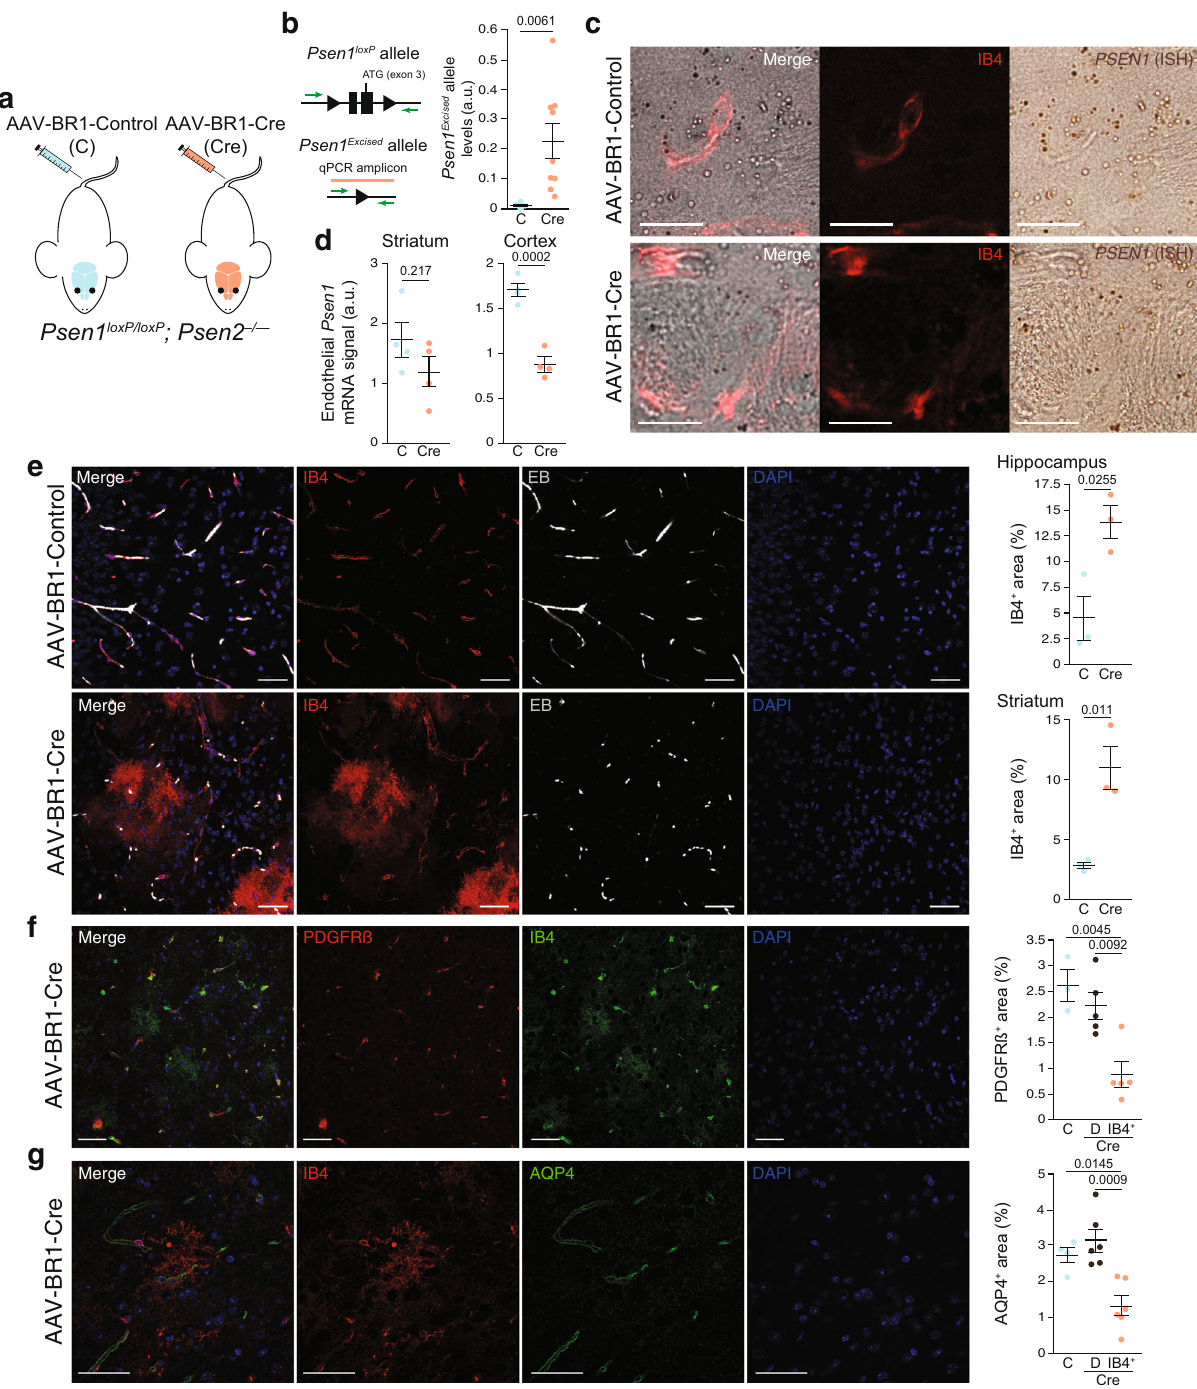
Fig. 4 In adult inhibition of endothelial γ -secretase activity is suf fi cient to generate IB4 + vascular abnormalities. a Schematic representation of a mouse model with adult inhibition of endothelial γ -secretase activity. Psen1 loxP/loxP ; Psen2 – / – mice were injected with cerebral endothelium-speci fi c adeno- associated control (AAV-BR1-Control; C) or Cre recombinase-expressing (AAV-BR1-Cre; Cre) viruses. b Schematic representation of the qPCR amplicon used to detect the Psen1 excised allele (orange bar). Right graph: Quanti fi cation of the degree of Psen1 excision (a.u., arbitrarty units) in the striatum of C and Cre mice. Mean ± SEM. n = 3 C and 10 Cre mice; Student ’ s t -test. c Striatal confocal XY images from C and Cre mice stained with endothelial (IB4; red) and Psen1 (ISH; brown) markers. Scale bar = 20 µ m. d Quanti fi cation of endothelial Psen1 + signal in the striatum (left graph) and the cortex (right graph) of C and Cre mice. Mean ± SEM. n = 4 mice; Student ’ s t -test. e – g Confocal projections of striatal ( e ) or hippocampal slices ( f , g ) from Psen1 loxP/loxP ; Psen2 – / – mice injected with AAV-BR1-Control or AAV-BR1-Cre viral vectors, and, 2 months later, perfused with Evans blue (EB; white — e ) and stained with endothelial (IB4; red — e , g — or green — f ), pericyte (PDGFRß; red — f ), astrocytic end-feet (AQP4; green — g ), and nuclear (DAPI; blue) markers. Scale bars = 40 µ m. Right graphs are the quanti fi cation of: e percentage of area occupied by IB4 + in C and Cre mice in hippocampus (upper row) and striatum (lower row). Mean ± SEM. n = 3 mice; Student ’ s t -test. f , g Percentage of area occupied by PDGFRß + ( f ) or AQP4 + ( g ) signal (in distal — D — vessels and in IB4 + area) in hippocampus form C and Cre mice. Mean± SEM. n f = 3 C and 5 Cre mice; n g = 4 C and 6 Cre mice ANOVA, post hoc Tukey ’ s